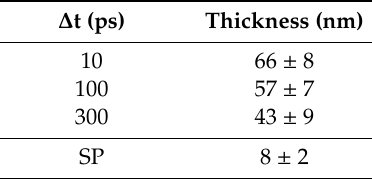
Figure 3. ( a ) Atomic Force Microscopy (AFM) images obtained in deposits prepared by DP and SP irradiation with 1 × 10 6 double pulse sequences and 1 × 10 6 individual pulses, respectively. ( b ) Example of AFM profiles obtained from the deposits. The profiles shown correspond to an average of around 10–20 individual profiles. ( c ) AFM topography images. ( d ) Size histograms of the nanoparticles and corresponding lognormal fitting (colour lines). Table 1. Averaged thickness values of the deposits obtained by DP irradiation with a train of 10 6 pairs of pulses at different interpulse delays ( Δ t) and by SP irradiation with a train of 10 6 pulses.